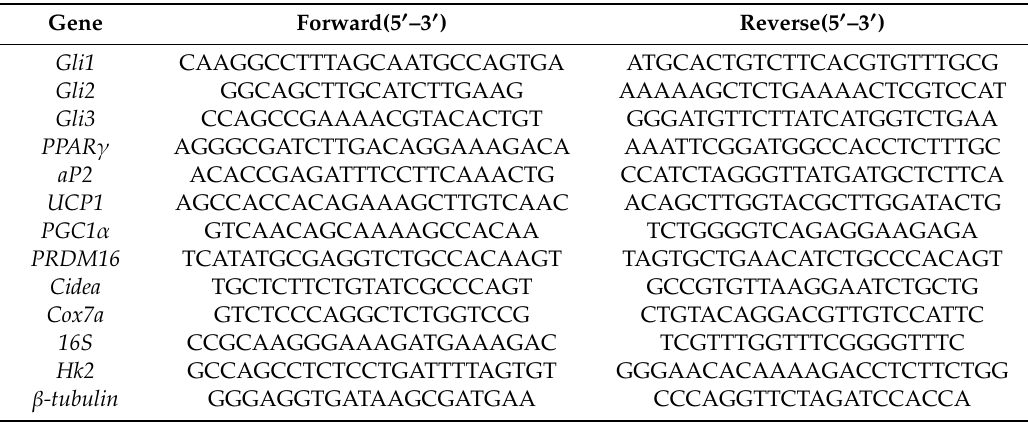
Table 1. Sequences of primers for RT-qPCR in this